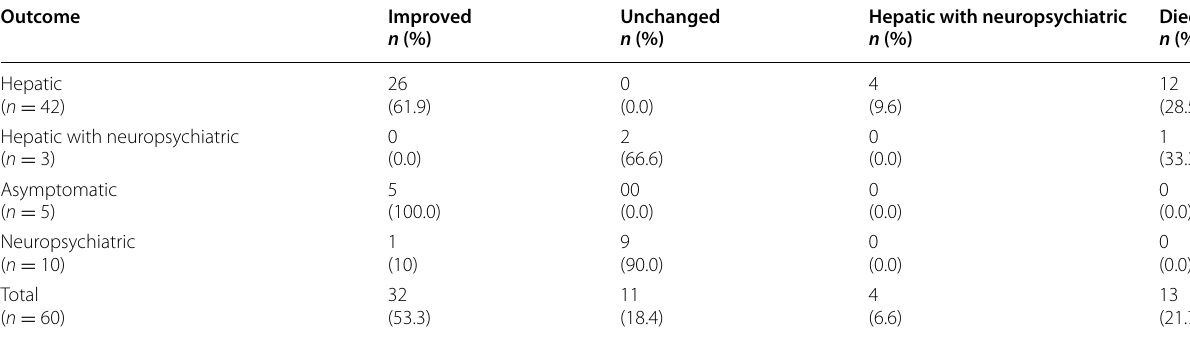
Table 2 Outcome of WD in different clinical presentation ( n